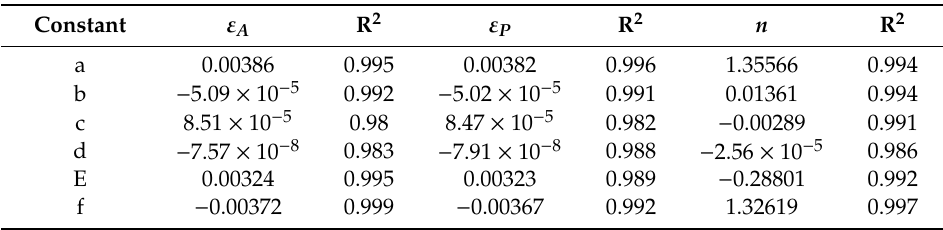
Table 2. Fitting constant values.